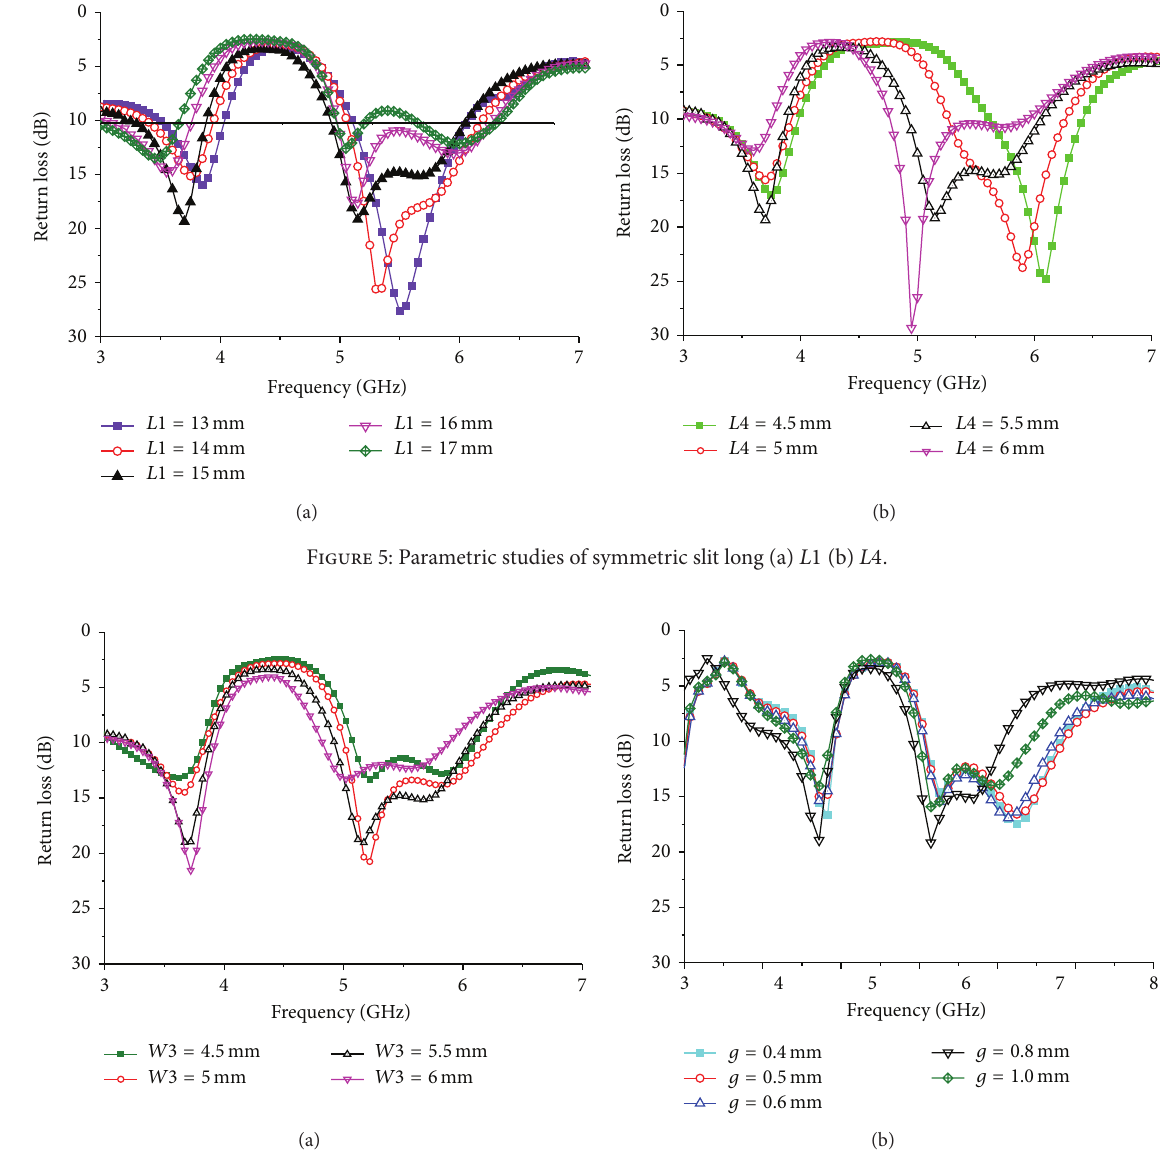
null point located there. Figure 8(c) indicated that the right hand side pair of strips is excited better that other